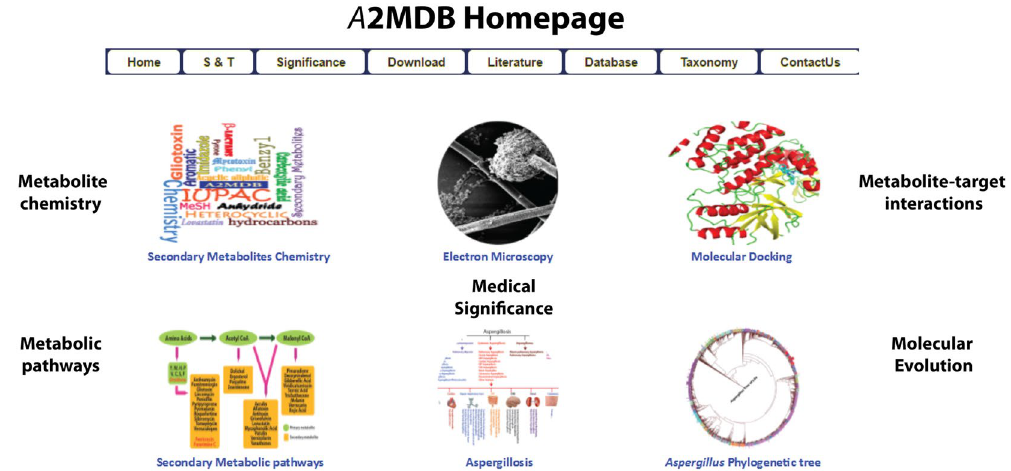
Figure 1. A screenshot of A2MDB showing multiple features in the homepage. The figure shows how clicking on various icons can navigate to the required option. Main page has icons for secondary metabolites chemistry, biological targets, Secondary metabolic pathways, microscopy images, molecular docking, Aspergillosis and phylogenetic analysis, apart from buttons which when clicked, explain science and significance of the project, database pages where one can surf and download data, taxonomy and contact us pages. The database has been officially launched through CSIR-IICT, India